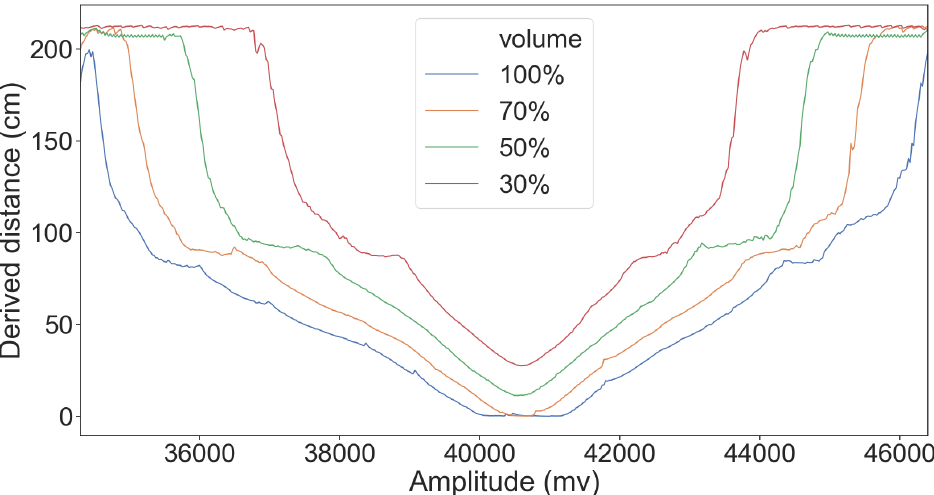
Figure 7. The effect of different combinations of attacker signal frequencies and strength on the sensor readings when there is no object in the sensor range.